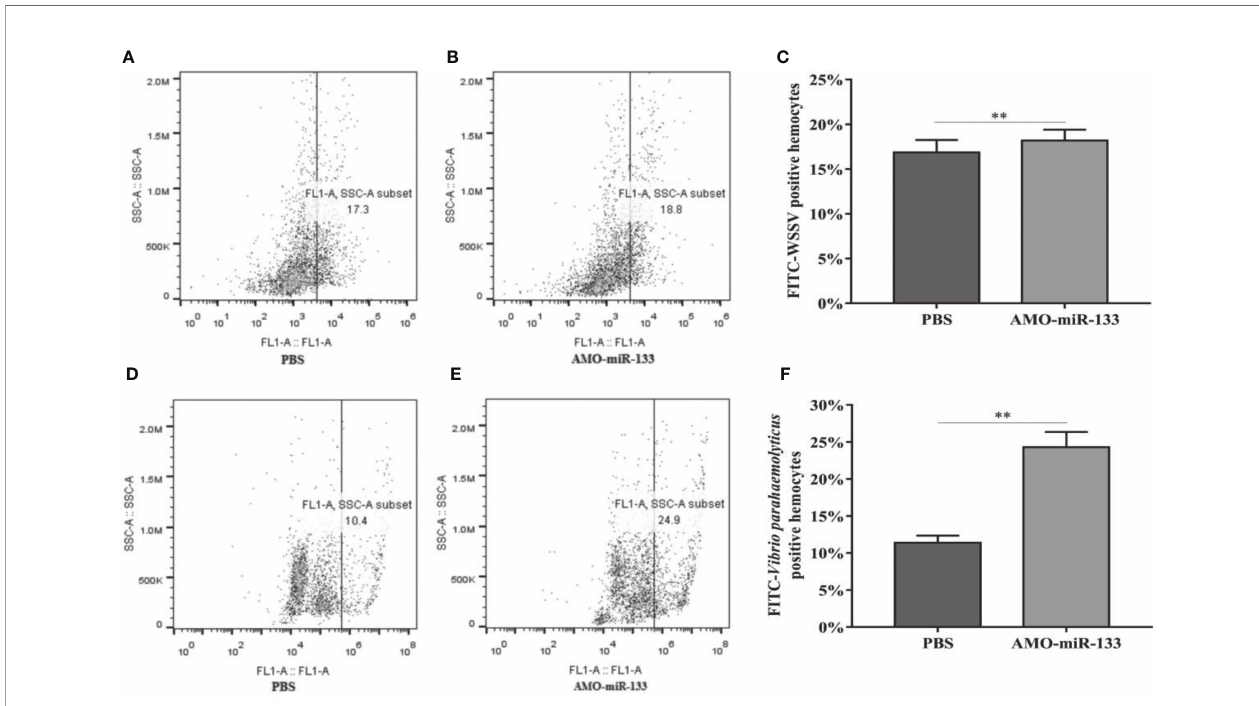
FIGURE 7 | Flow cytometry assay of hemocyte phagocytosis. Inactivated WSSV was labeled with FITC. (A) PBS group. (B) AMO-miR-133 group. (C) Bar graph of phagocytosis of WSSV. (D) PBS group. (E) AMO-miR-133 group. (F) Bar graph of phagocytosis of V. parahaemolyticus. Signi fi cant difference between different samples is indicated by ** P <